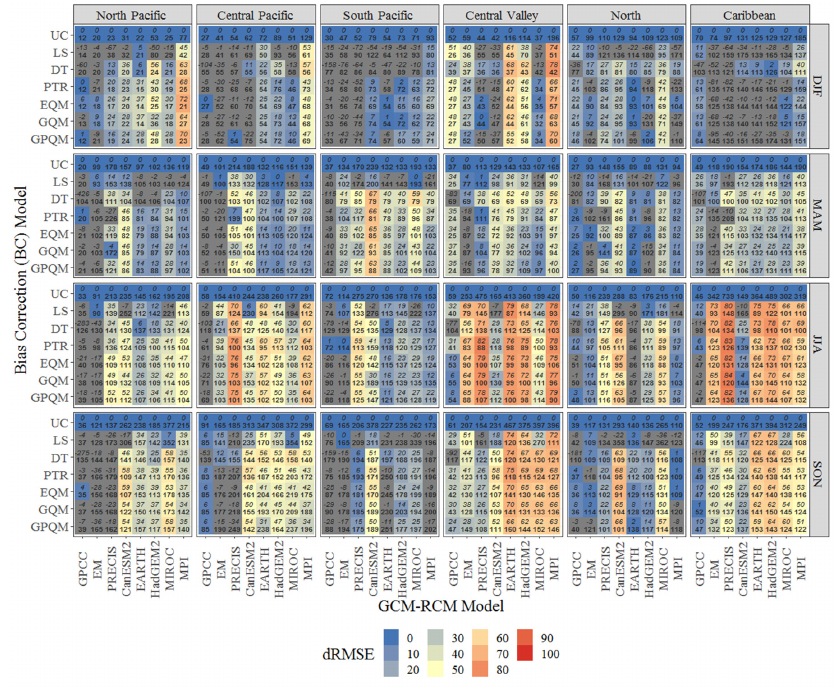
Figure 6. Spatially-averaged root mean square error (RMSE) performance of uncorrected and bias-corrected precipitation during the validation period 1981–1995 for all climatic regions of Costa Rica. Bold cell numbers represent absolute RMSE values (mm / month), whereas italic numbers and scale-color represent the RMSE relative percentage change after bias correction (%). Negative values are presented in grey. Water 2020 , 12 , 482